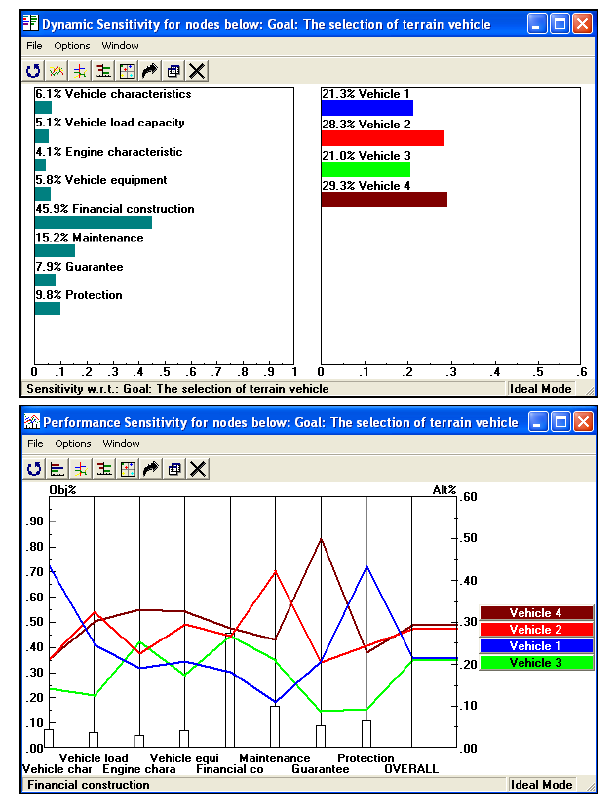
Figure 16. Economic construction is the most important criteria